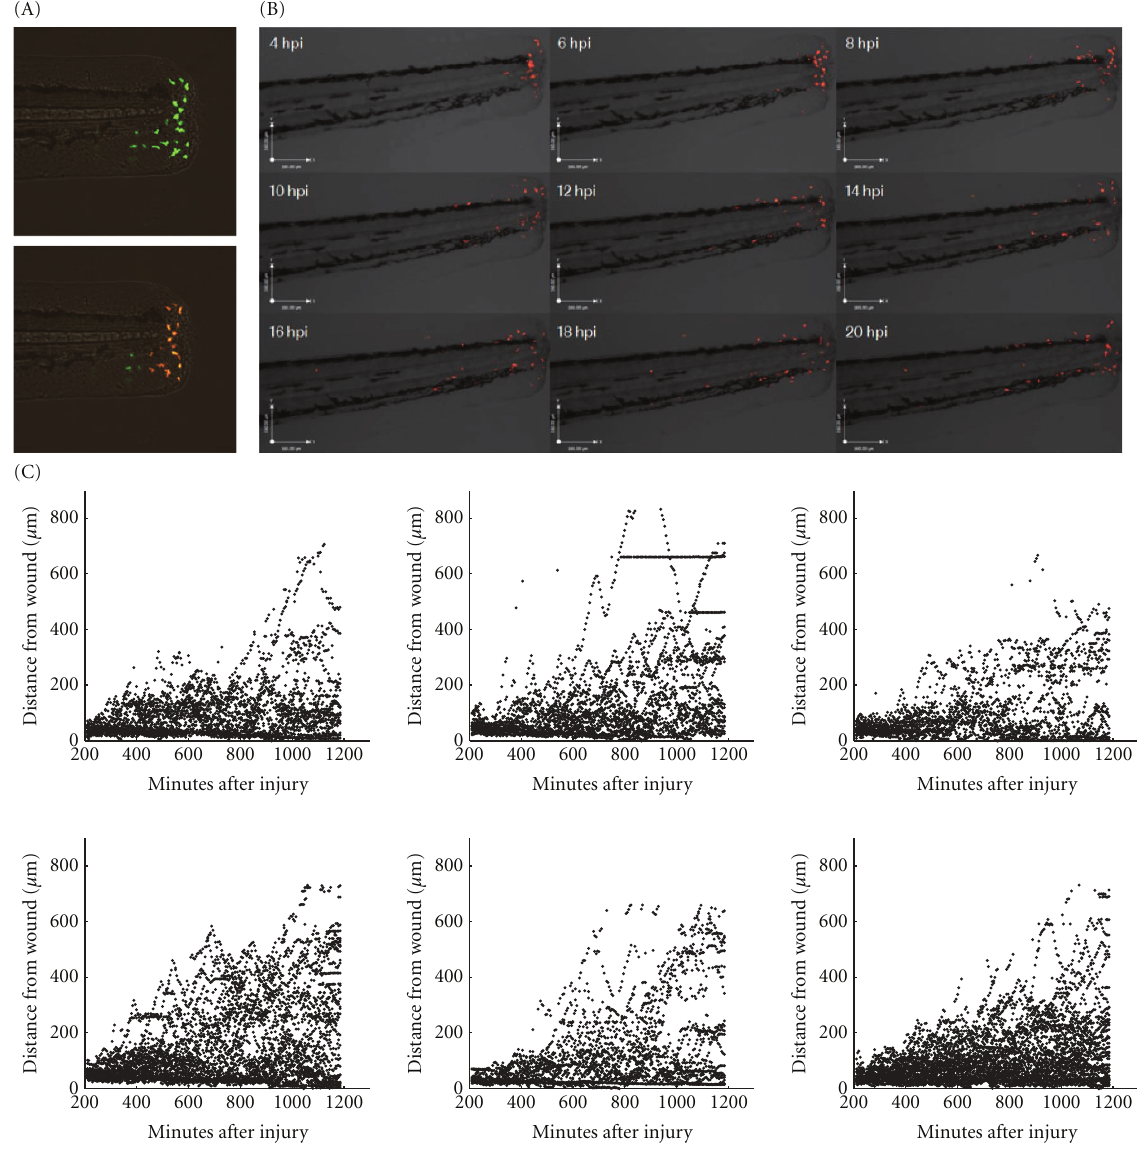
Figure 1: Inflammatory neutrophils exhibit restricted migration away from the site of tissue injury. 3 dpf embryos from transgenic zebrafish expressing Kaede in neutrophils were subjected to tailfin transection under anaesthesia using a sterile scalpel. The embryos were recovered for 4 hours. At four hours after injury the embryo was mounted in 0.5% low melting point agarose for imaging on a Laser Confocal System (Perkin Elmer Inc). The PhotoKinesis device was then used to photoconvert all neutrophils present within the tip of the tailfin. Photoconversion was carried out according to the methods described (120 cycles of 40% 405 nm laser energy), and time-lapse videomicroscopy was performed using a TE2000 fluorescent inverted microscope (Nikon). (a) Composite images of DIC overlaid with the red and green fluorescence channels showing a representative zebrafish tail before (above) and after (below) photoconversion. (b) A montage of DIC images overlaid with the red fluorescence channel at then timepoints indicated after tailfin injury. The redistribution of photoconverted cells can be clearly seen over time. (c) For each neutrophil in six individual fish, the distance from the wound was calculated using algorithms within Volocity and plotted against